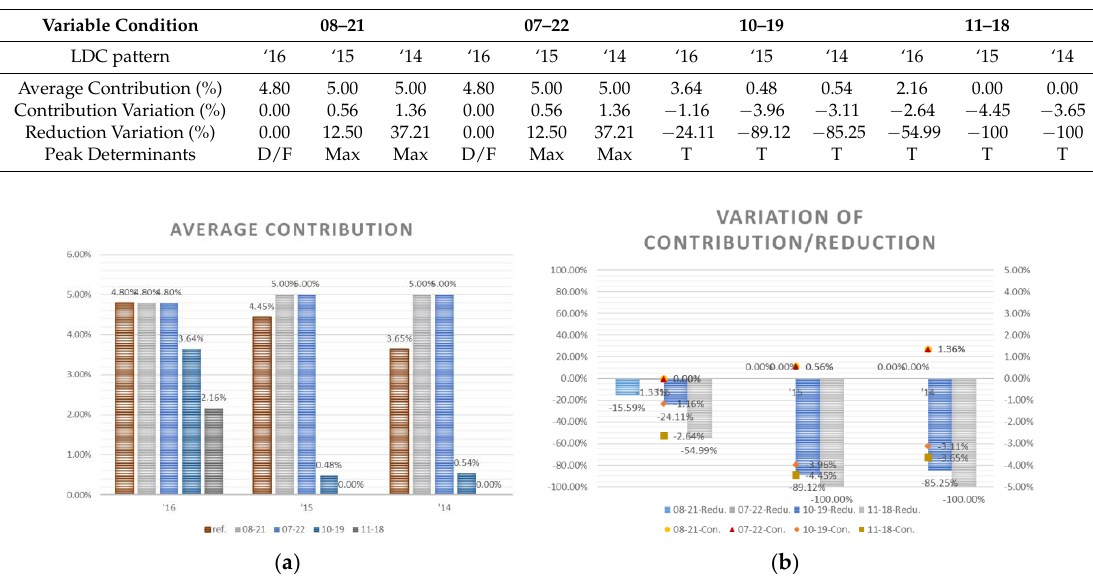
Figure 3. Sensitivity simulation results of dispatchable Time constraint: ( a ) Average contribution; ( b ) Variation of contribution and reduction.